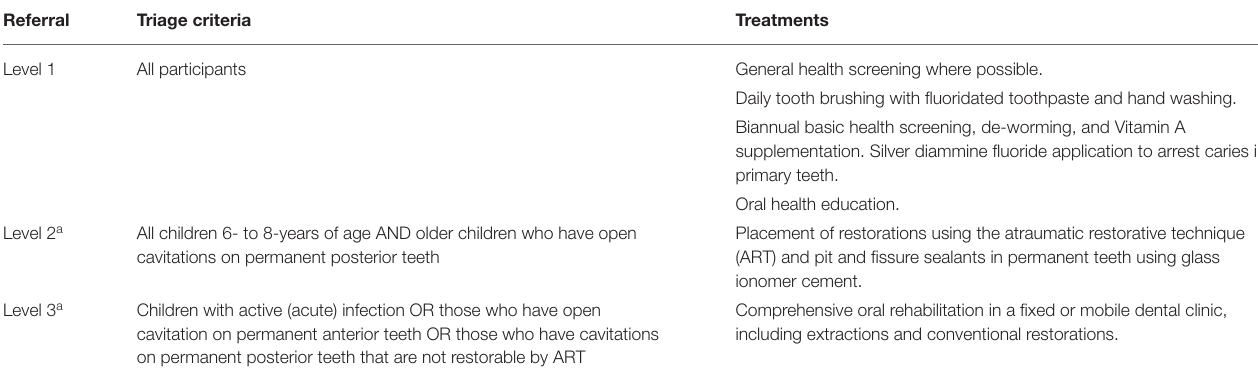
TABLE 1 | The three-tiered system used to triage children based on clinical presentation and treatment needs.